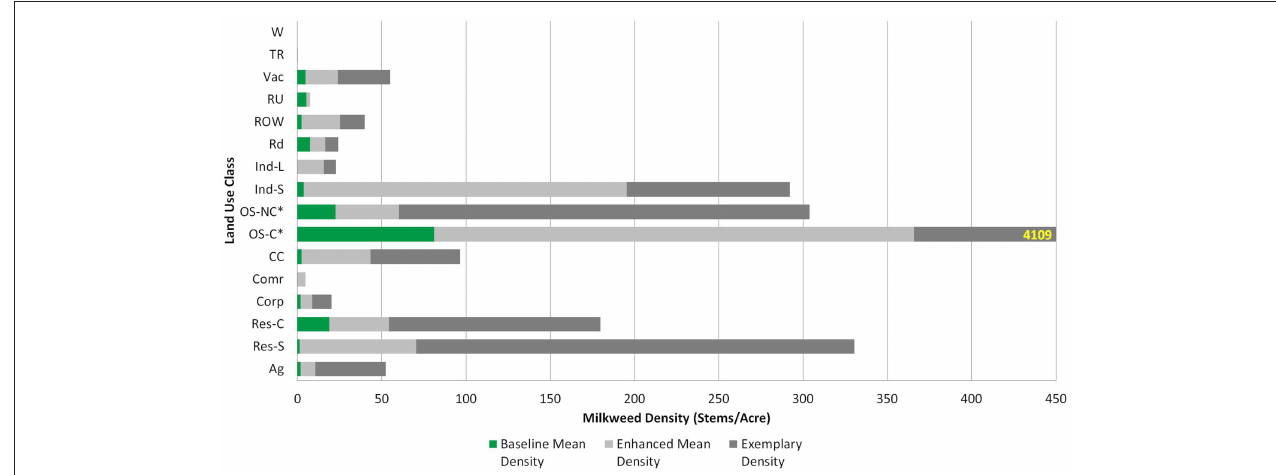
FIGURE 8 | Chicago average milkweed stem densities by consolidated land use categories are shown for existing “baseline” densities (green bars), “enhanced” densities (light gray), and “exemplary” densities (dark gray). *For open space conservation and non-conservation, the baseline density values were provided by Thogmartin et al. (2017b). The mean exemplary density for open space conservation extends well beyond the plotted space.